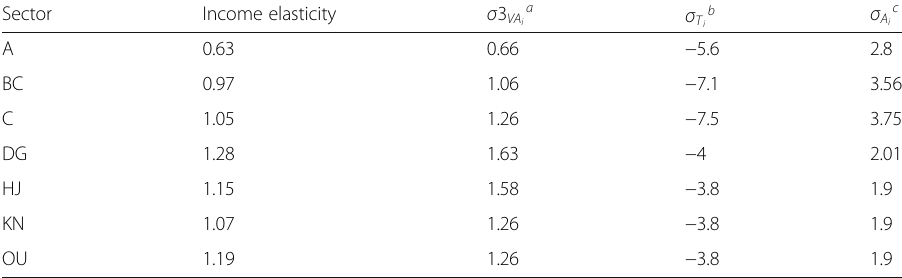
Table 2 Predetermined parameters by sector Sector